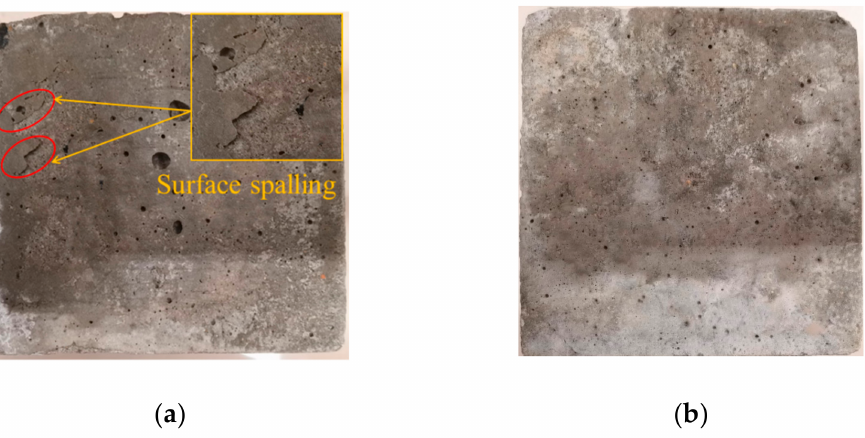
Figure 13. Appearance of specimens after 120 d immersion: ( a ) Reference group; ( b ) hybrid fiber